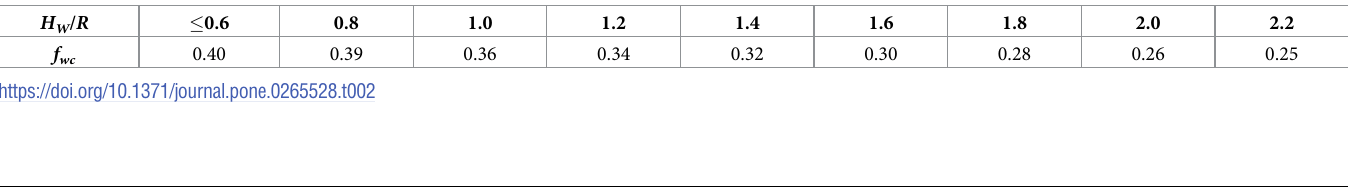
of a circular wc